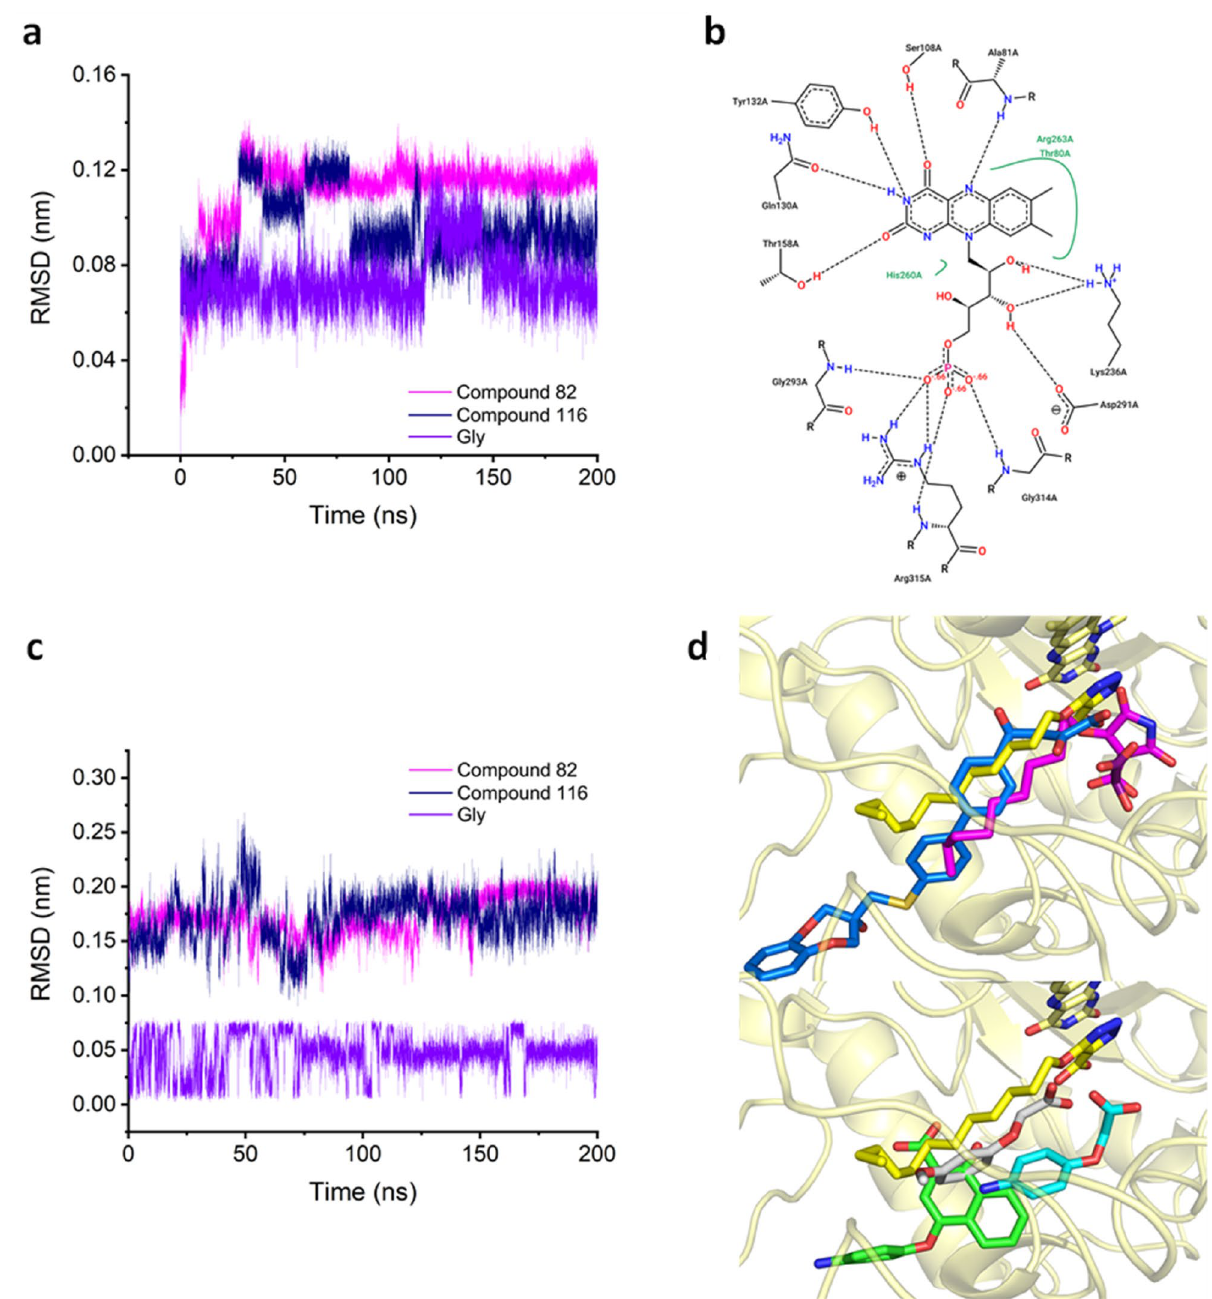
Figure 10. ( a ) RMSD of FMN during the 200 ns simulation. ( b ) 2D representation of the interaction between FMN and GO. ( c ) RMSD of the ligands during the 200 ns simulation. ( d ) Comparison of the structure after 200 ns simulation vs. experimental CDST